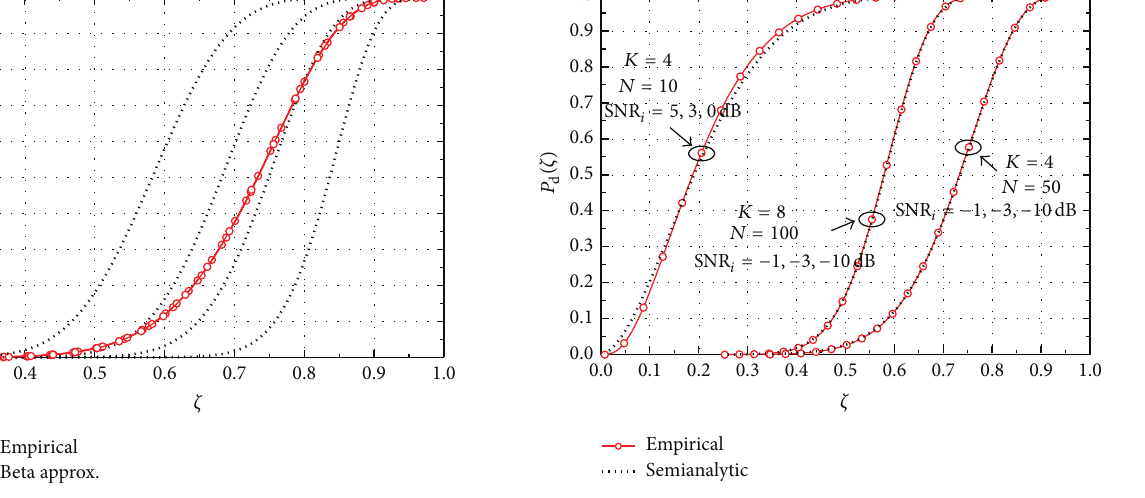
Figure 9: Empirical and semianalytic results for the ST, considering Figure 8: Variation of the theoretical detection probability of the a Rayleigh fading ST with four different realizations of the channel matrix, for 𝐾 = 4, = − 1 dB, SNR = − 3 dB, and SNR = − 10 dB. 𝑁 = 50, 𝑃 = 3, SNR 1 2 3 Scenario D: time-varying and nonnormalized channel.